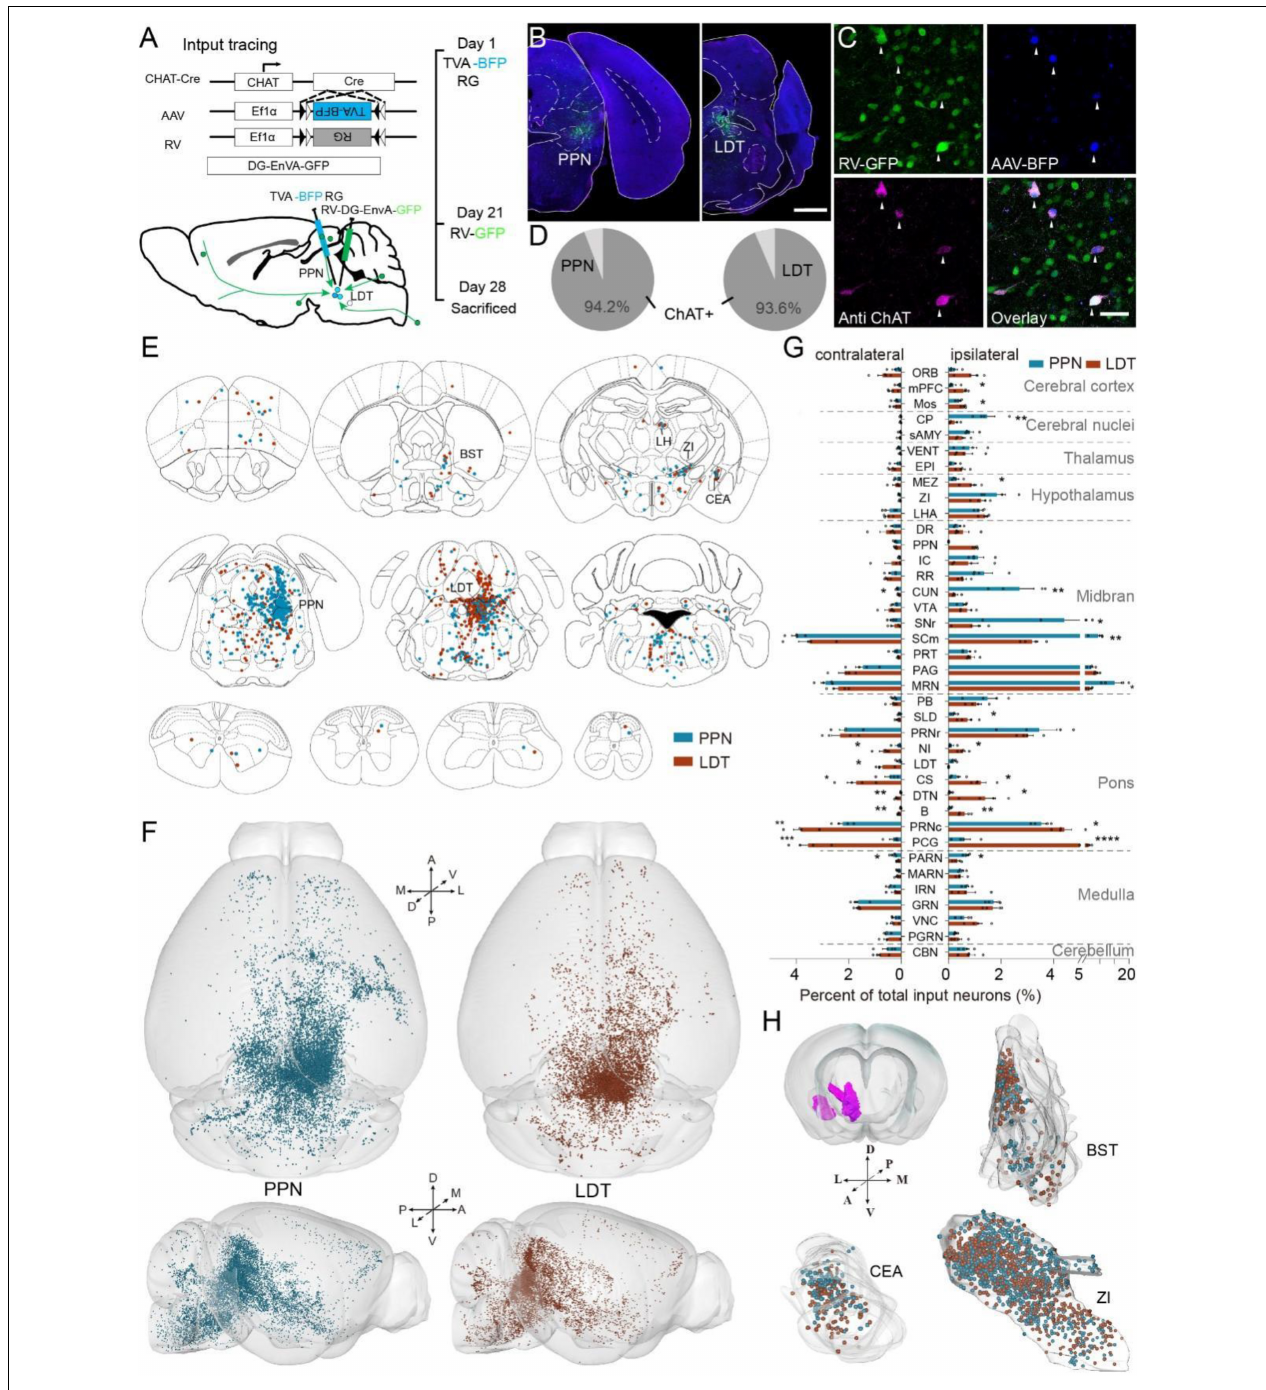
FIGURE 1 | Whole-brain input of pontomesencephalic tegmentum (PMT) cholinergic neurons. (A) The methods and processes for monosynaptic input tracing. (B) A typical coronal plane of an inject site. (C) Immunofluorescent staining of start cells. GFP-labeled neurons are input neurons. BFP-labeled neurons are infected by an AAV helper. RFP represents cholinergic neurons. The neurons co-labeled with BFP, GFP, and RFP are start cells; arrows point out start cells. (D) The proportion of ChAT-positive start cells, PPN = LDT = 4 mice. (E) Input neurons of ChAT PPN and ChAT LDT distribute in the whole-brain widely. (F) The 3D view of whole brain input neurons. Left displays the whole-brain input to the PPN; right represents LDT. (G) Quantitative statistical proportion of main input regions to whole-brain input neurons. The left side of vertical axis represents proportion of input neurons in the contralateral hemispheres, and the right side represents ipsilateral hemispheres. (H) The spatial distribution of input neurons in the BST, CEA, and ZI. A scale bar, (B) 1,000 µ m; (C) 50 µ m. The abbreviations of brain regions are provided in Supplementary Table 1 . Data are shown as mean ± SEM. Two-sided t -tests, * p < 0.05, ** p < 0.01, *** p < 0.001, **** p < 0.0001; PPN = LDT = 4 mice; for detailed P values, see Supplementary Table 2